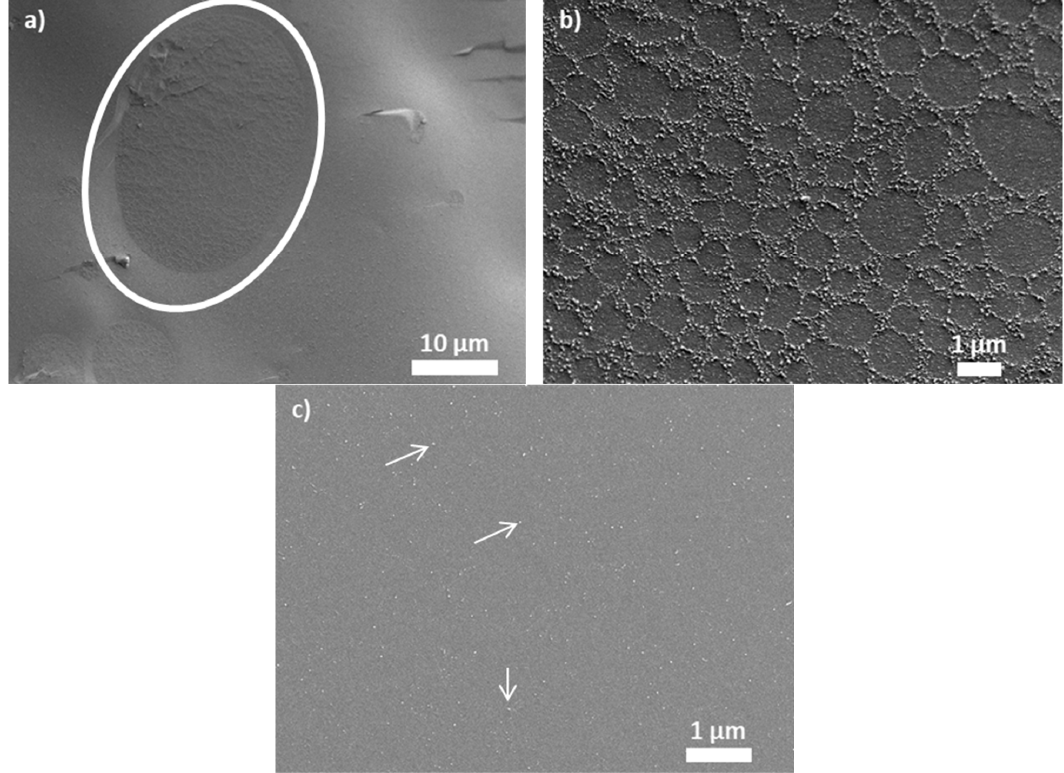
Figure 7. Morphology of asphalt blends obtained using Cryo-SEM: ( a ) 3.0 wt.% SBS D1101 magni- fied ×2000; ( b ) 3.0 wt.% SBS D1101 magnified ×10,000; ( c ) 3.0 wt.% SBS D1101 with 0.12 wt.% sulfur magnified ×15,000. magnified ×